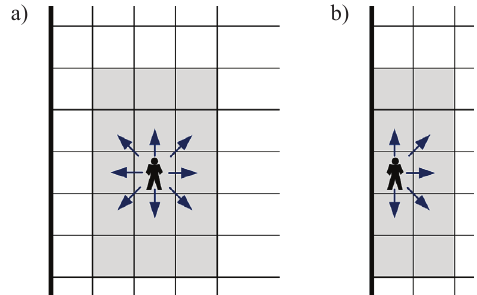
Fig. 5. Moving filed vs. vision-conscious field without/with a